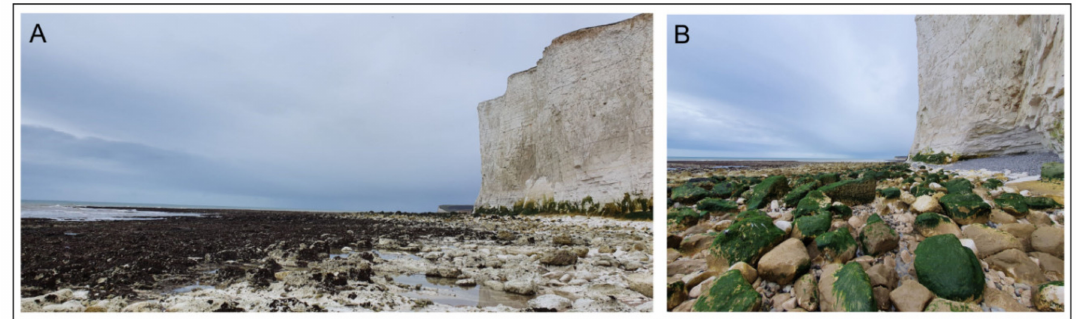
Figure 8. Flagsta ff Point platform at low tide. Photograph ( A ) shows the spread of the platform in front of the cli ff face, extending 200 m into the sea. Photograph ( B ) shows large chalk boulders spread on the platform, providing a good stable response to the radar